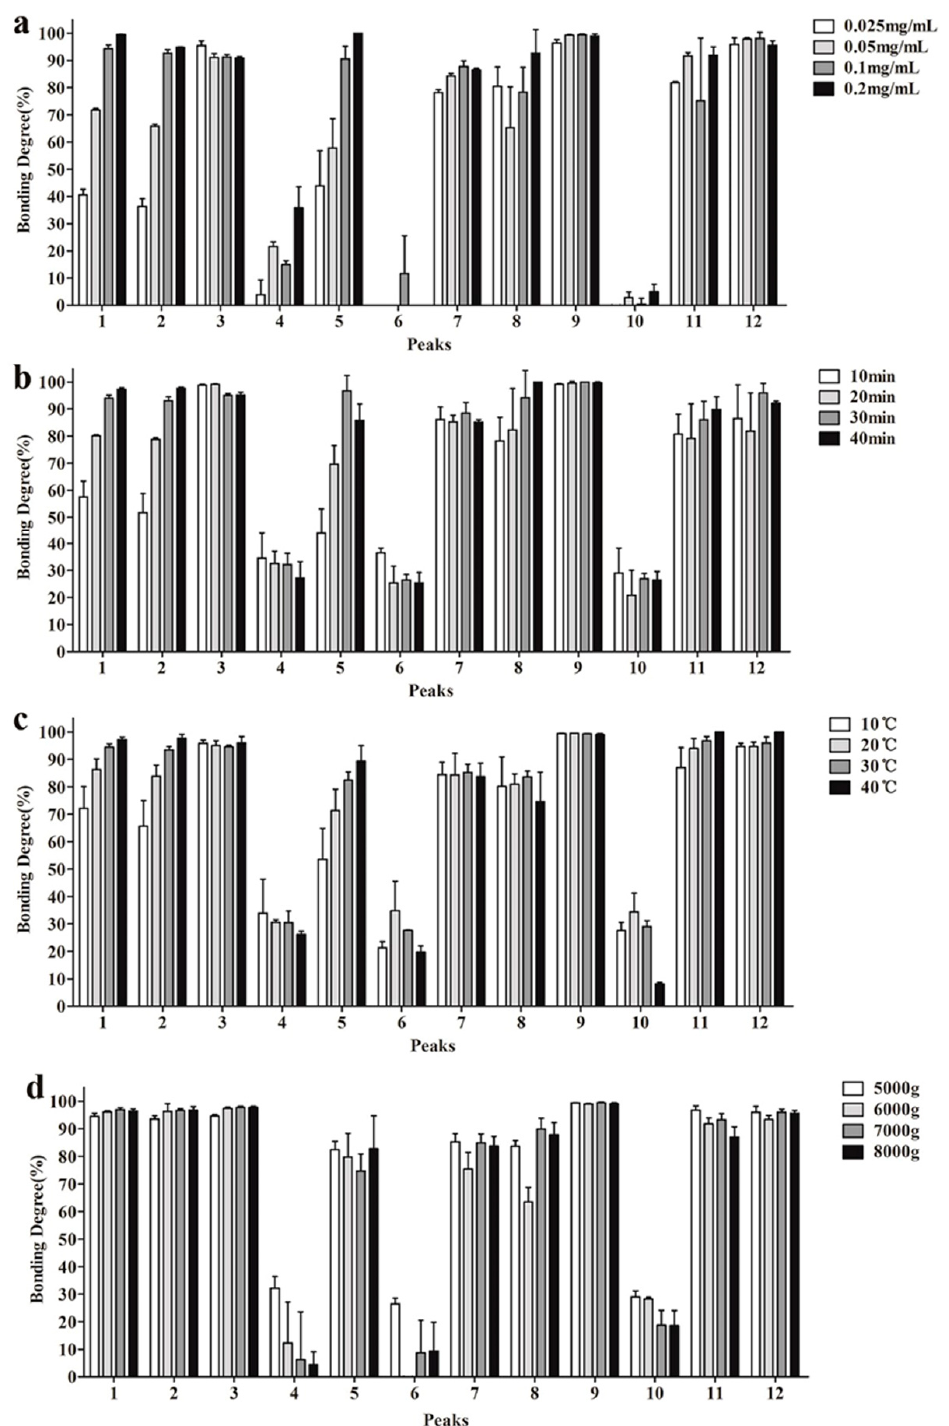
Figure 1. Optimization of tyrosinase (TYR) ultrafiltration parameters: ( a ) TYR concentration (0.025, 0.05, 0.1, 0.2 mg/mL); ( b ) incubation time (10, 20, 30, 40 min); ( c ) incubation temperature (10, 20, 30, 40 °C); ( d ) centrifugal force (5000×, 6000×, 7000×, 8000× g ) .